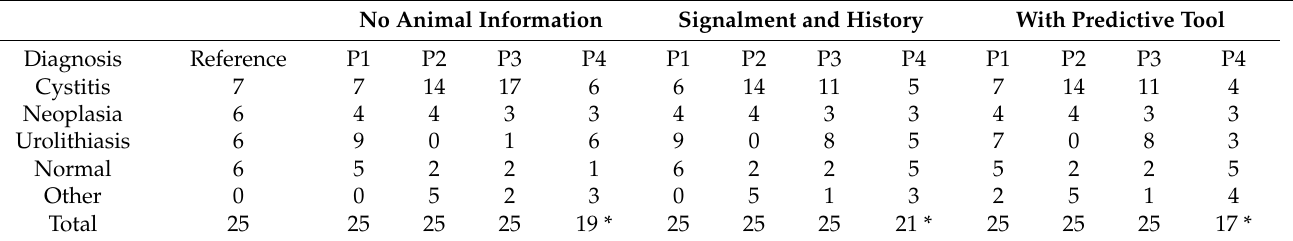
Table 3. Digital whole-slide image count data from all study pathologists, P1–P4.